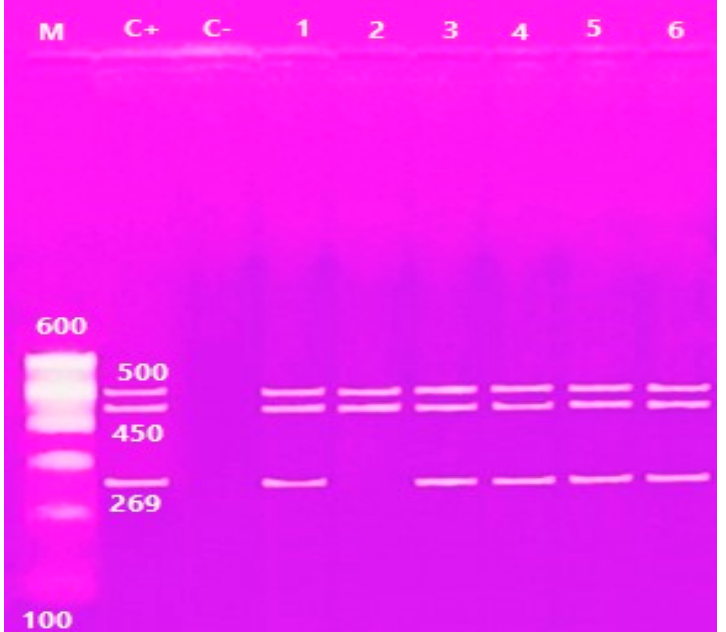
Figure 3. Agarose gel electrophoresis of multiplex PCR of trh (500 bp) tlh (450 bp) and tdh (269 bp)